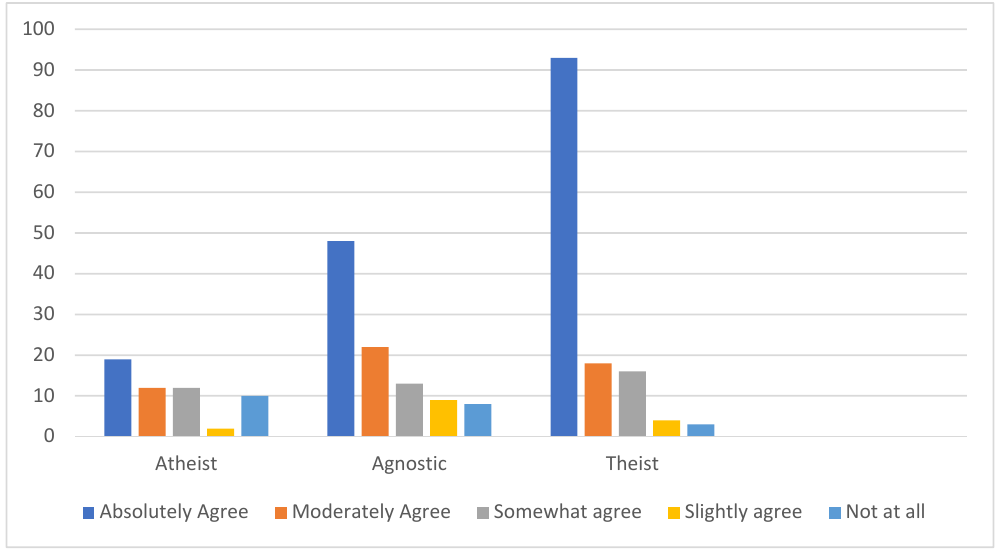
Figure 11. Cross-tabulation of Q15 belief about God(s) and Q24 Religion should be taught in a positive way in Religious Education (England, Scotland and Secondary only): n = 289.